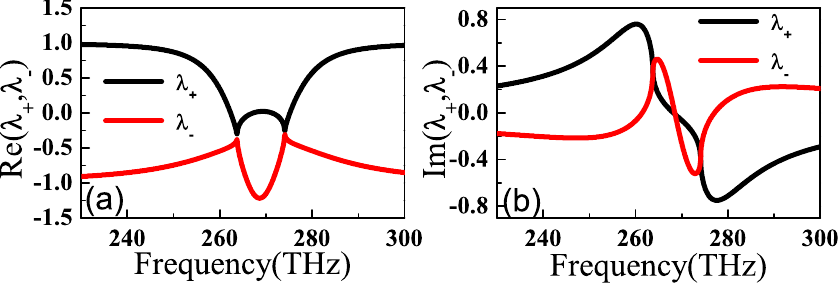
Figure 5. (Color online) Real ( a ) and imaginary ( b ) parts of eigenvalues λ ± of the scattering matrix S as the functions of frequency ω when ϕ = 0.967 π